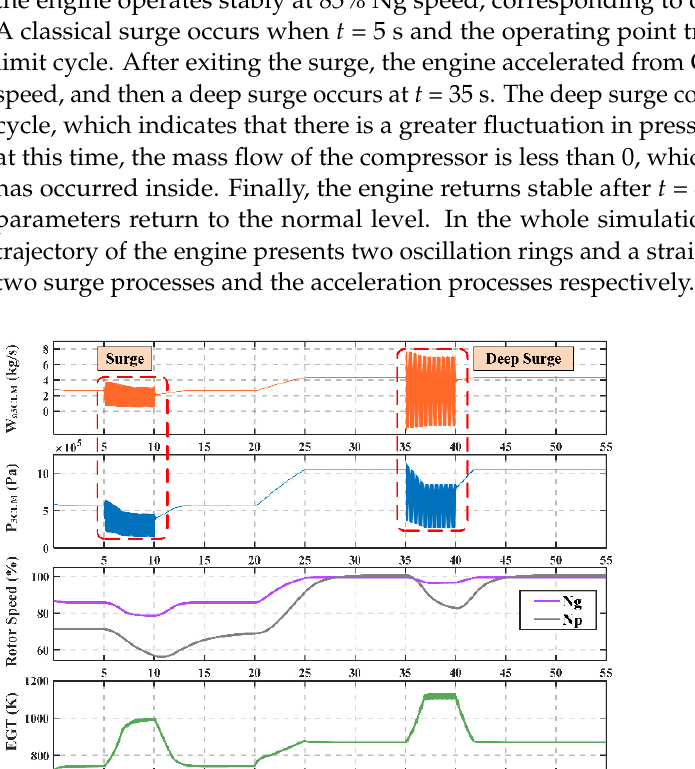
Figure 14. The engine’s operating trajectory in the surge dynamic process at multiple operating points. 4.3. Model Confidence Verification